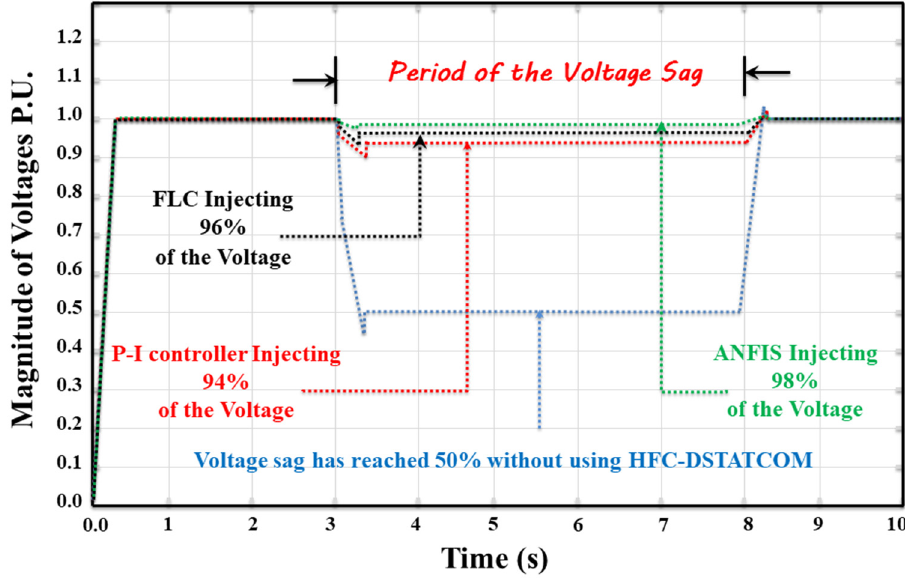
Figure 21. Illustrates the injection voltage by HFC D-STATCOM due to the Three Line-to-Ground Faults Scenario.